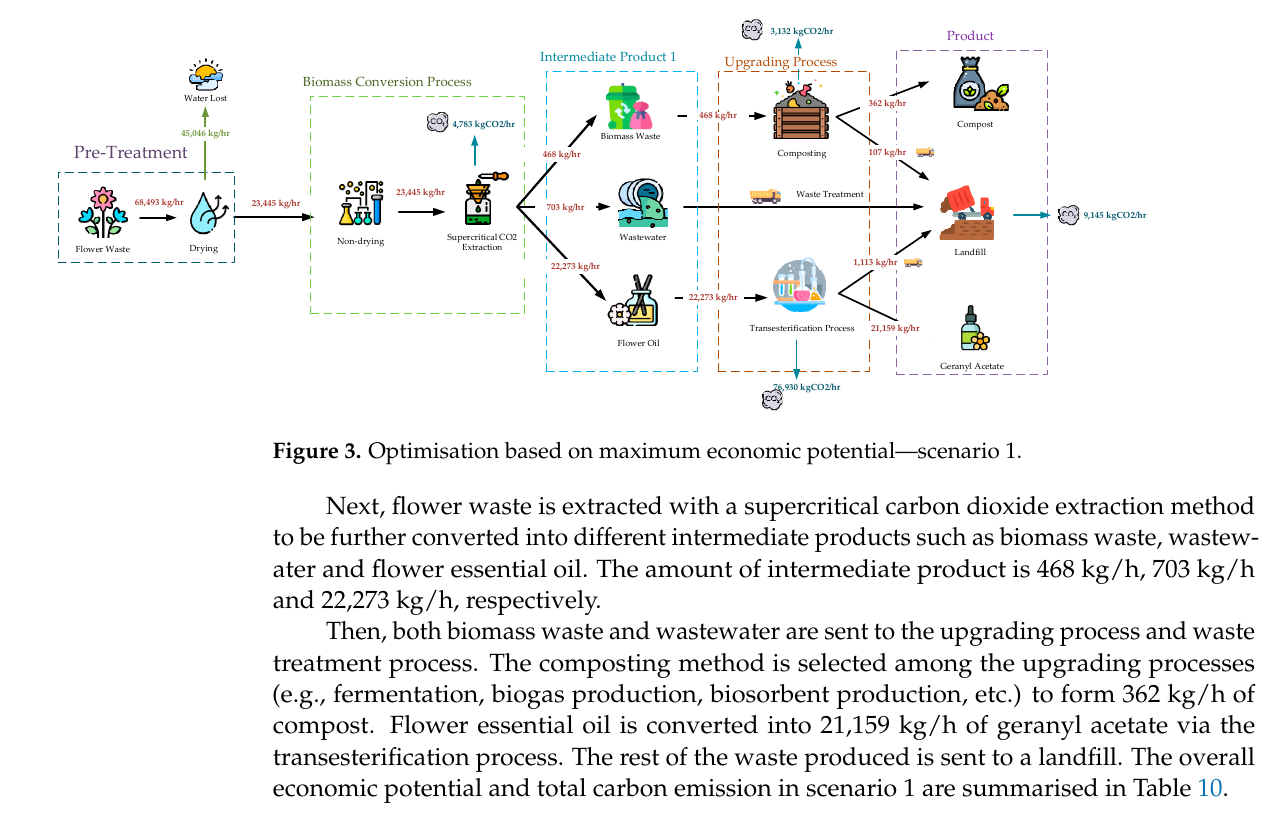
Table 10. Economic potential and environmental impact in scenario 1.